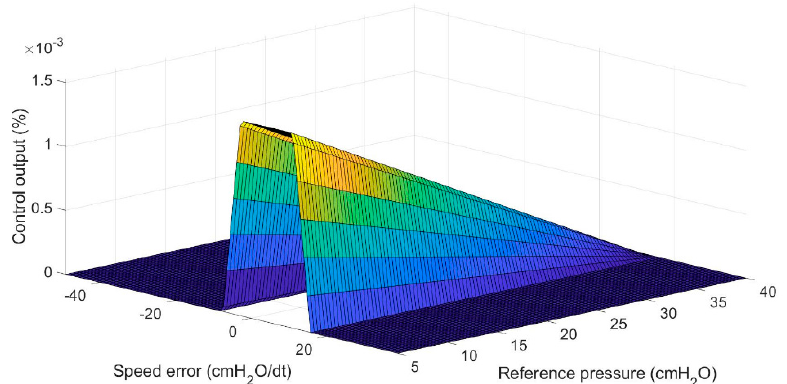
Figure 13. Influence of control error and reference pressure on final control output.